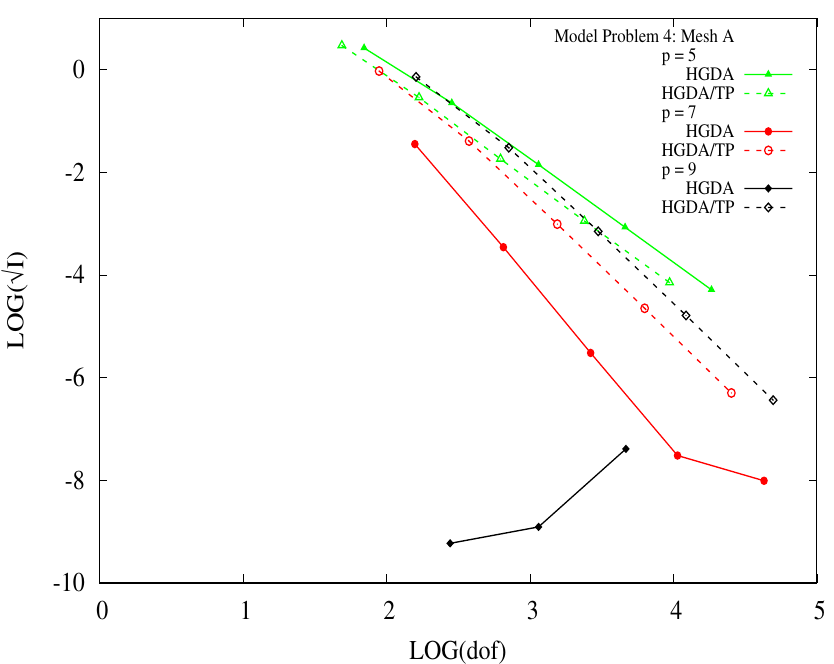
Figure 17. Residual function I versus dof, C 22 solutions: Model Problem 4 (Poisson’s Equation; Mesh A; HGDA/DG and